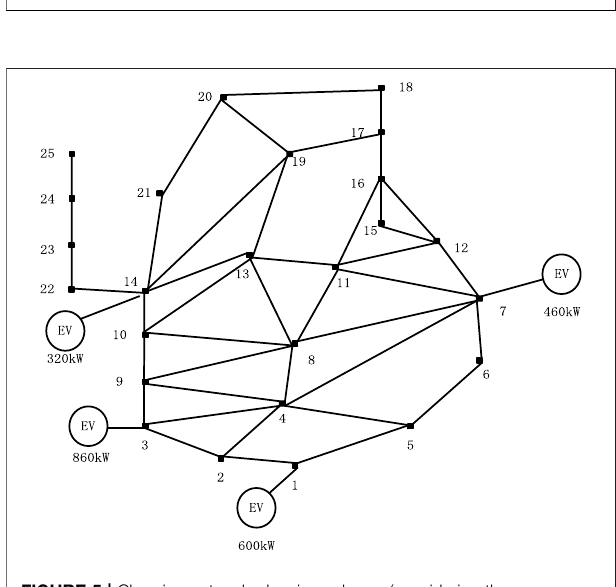
FIGURE 5 | Charging network planning scheme (considering the minimum network loss of a distribution